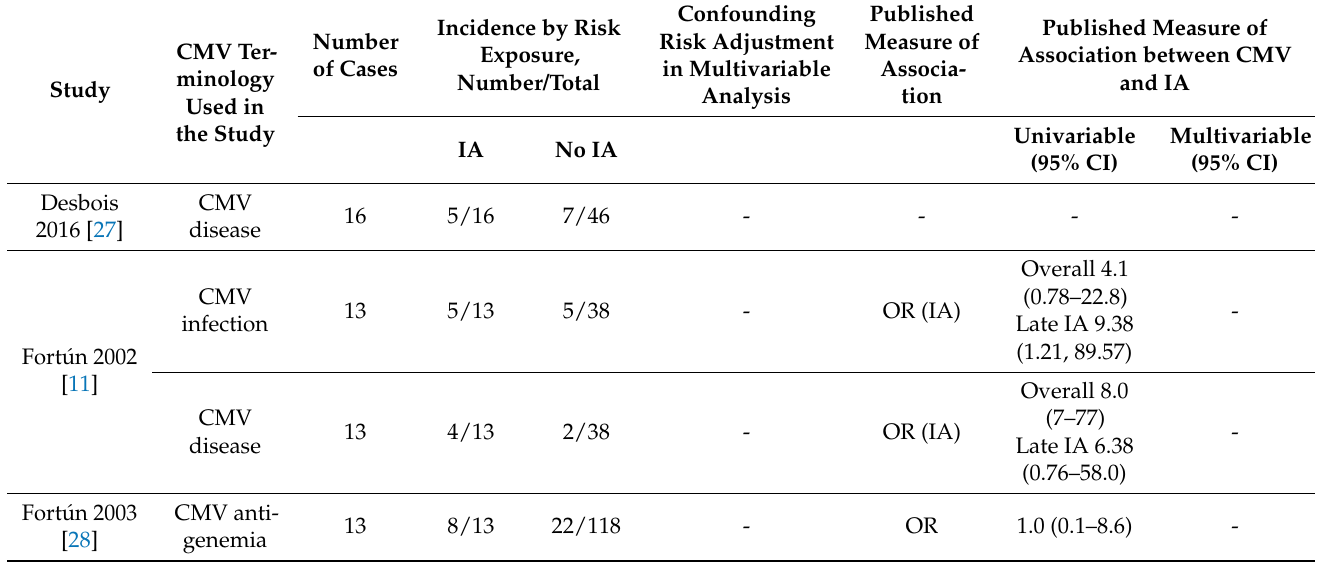
Table 2. Main results of the included